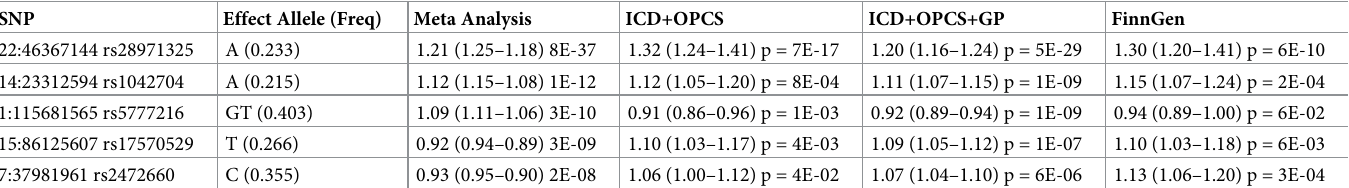
Table 2. Association of lead SNPs in the full meta analysis in the two input GWAS results (ICD+OPCS+GP in UKBB and FinnGen) and the UKBB result excluding GP records. The effect allele frequency is from the UK Biobank cohort. SNP Effect Allele